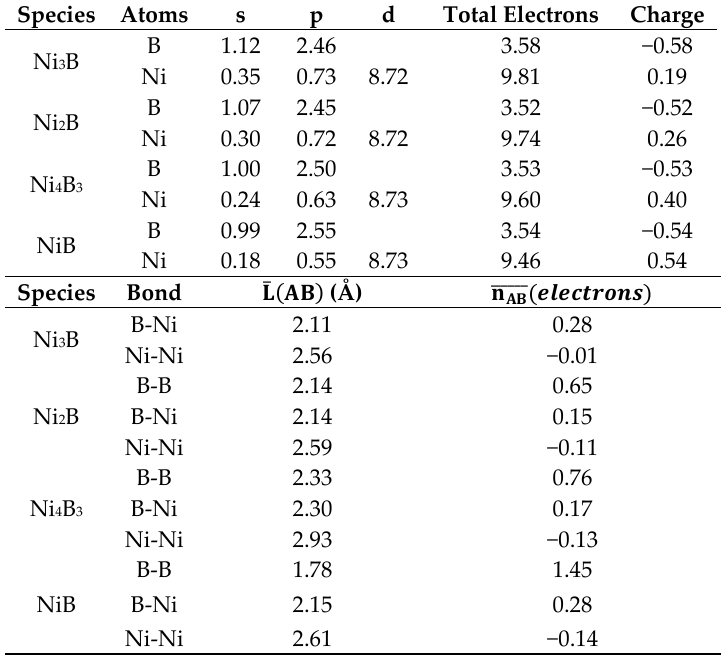
Table 5. Milliken population analysis results of Ni x B y , the unit of bond length is Å. Species Atoms s p d Total